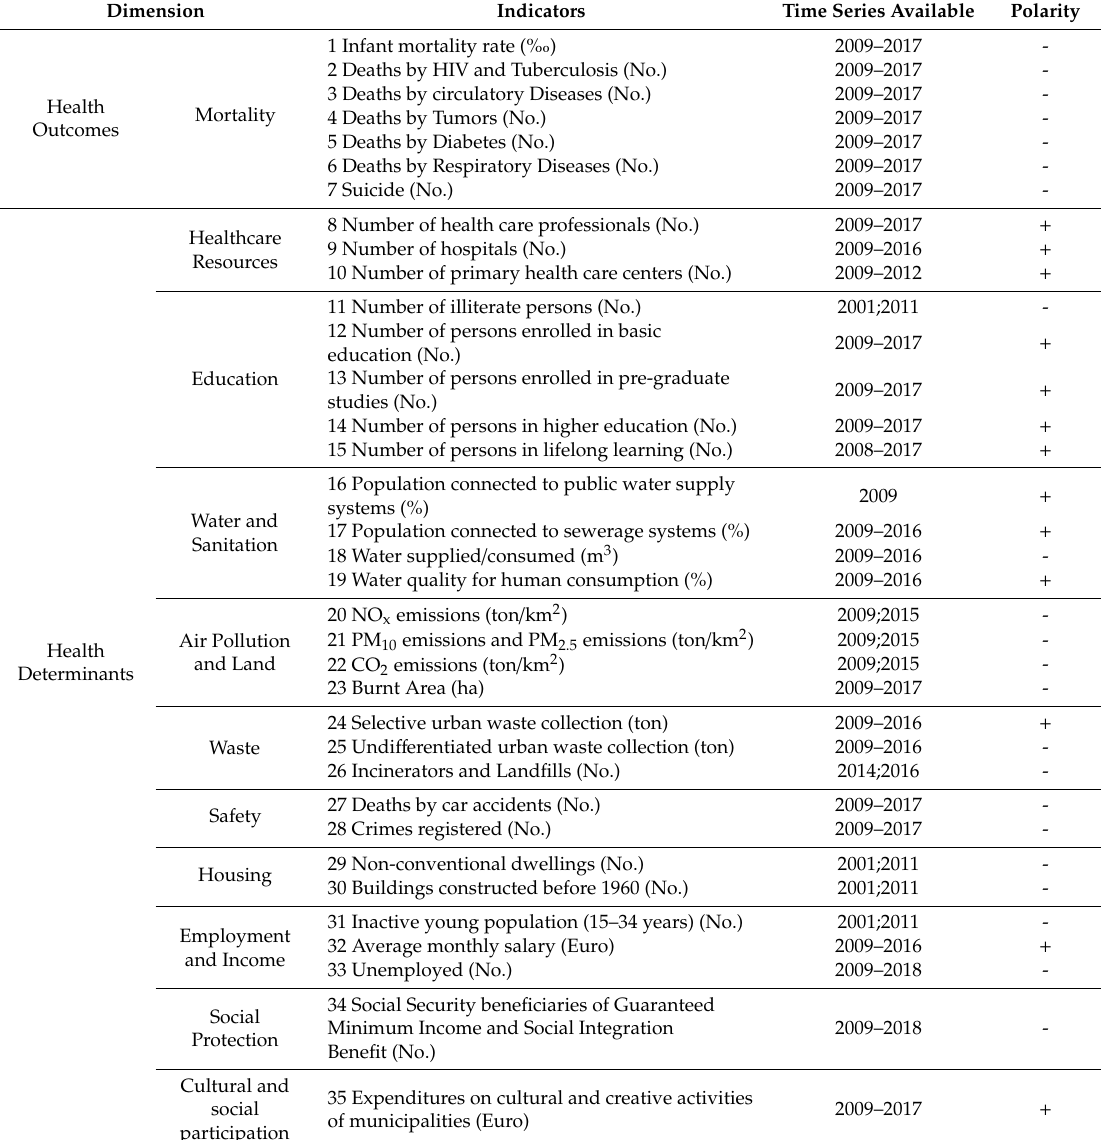
Table 1. Variables selected to compose socioeconomic health vulnerability index (SEHVI)